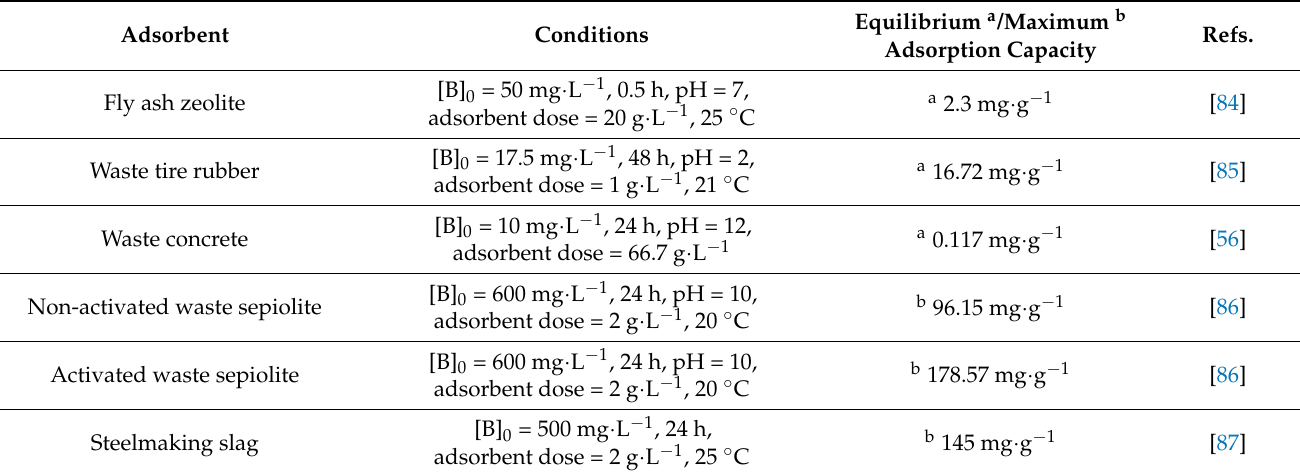
Table 11. Boron removal performances of waste industrial materials